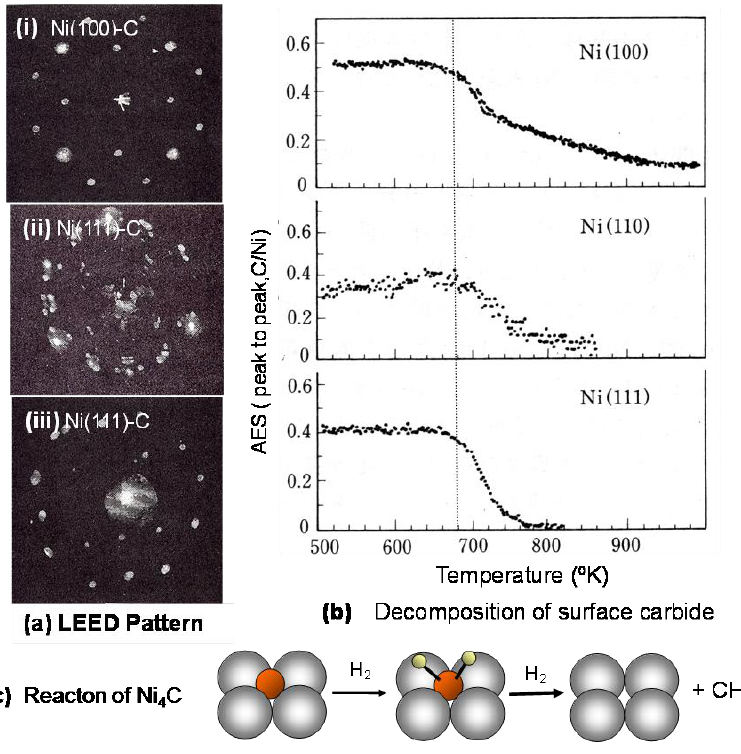
Figure 13. ( a ) LEED pattern of carbon segregated on Ni(111), Ni(100) and